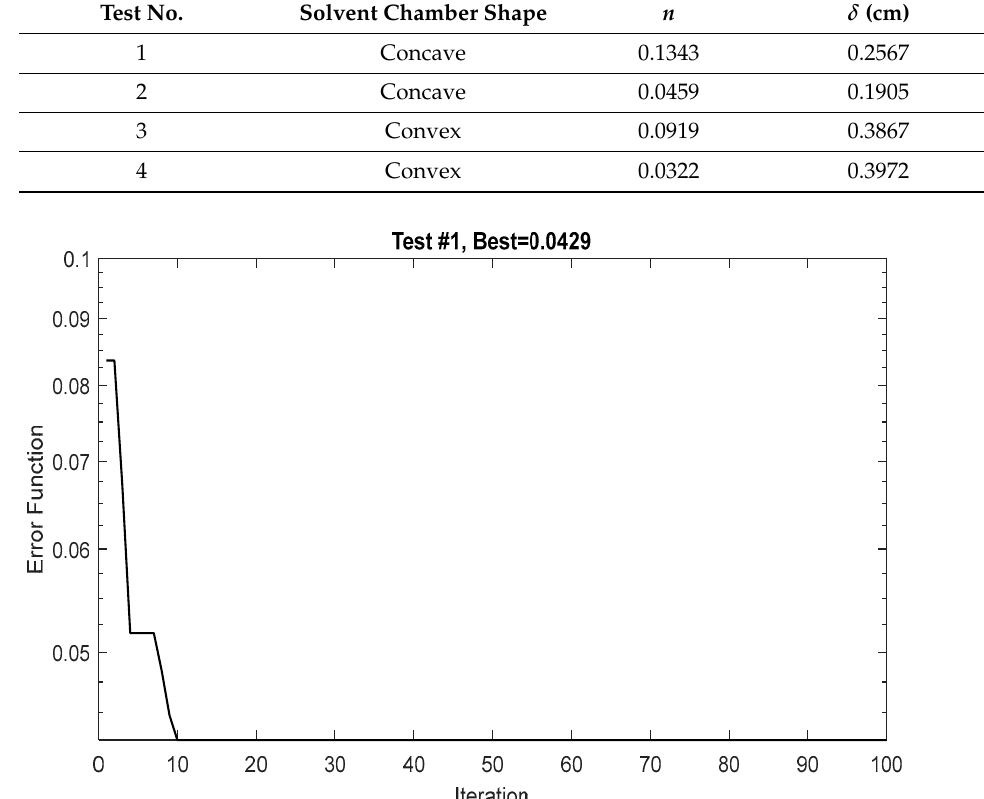
Table 2. The determined values of the unknown parameters. Test No.